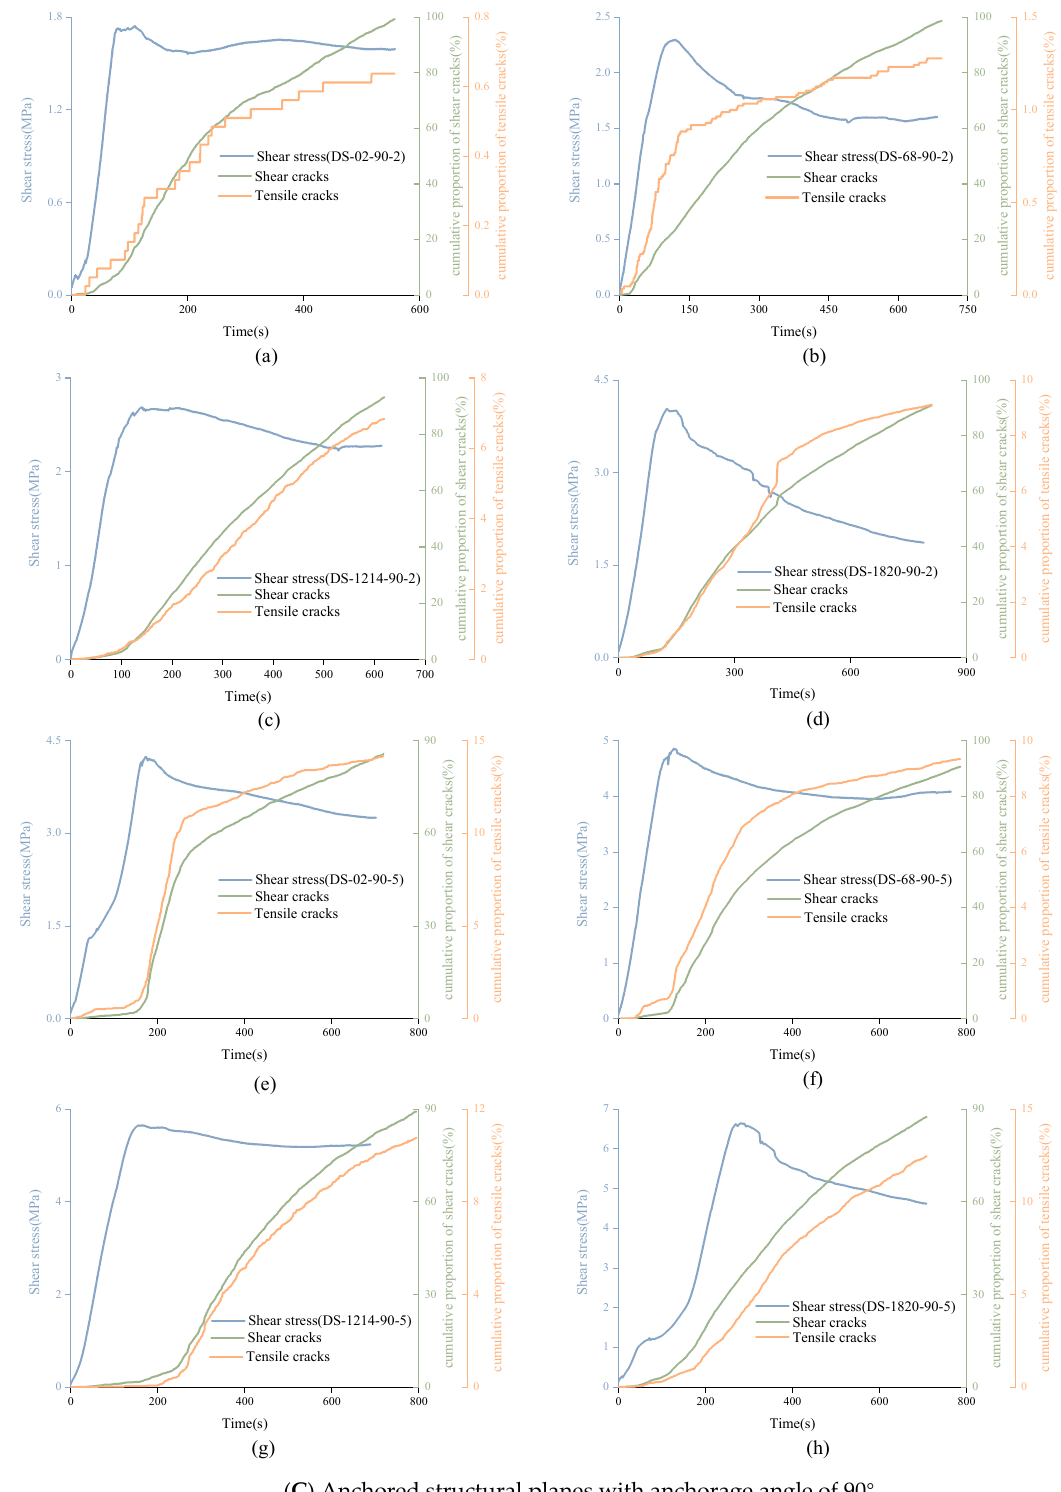
Figure 16. Variation trend of cumulative proportion of shear cracks and tensile cracks with